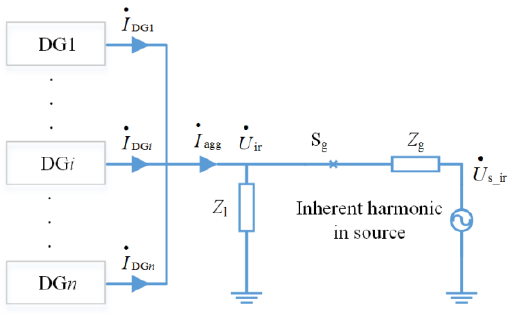
Figure 2. Irregular currents and irregular voltages.